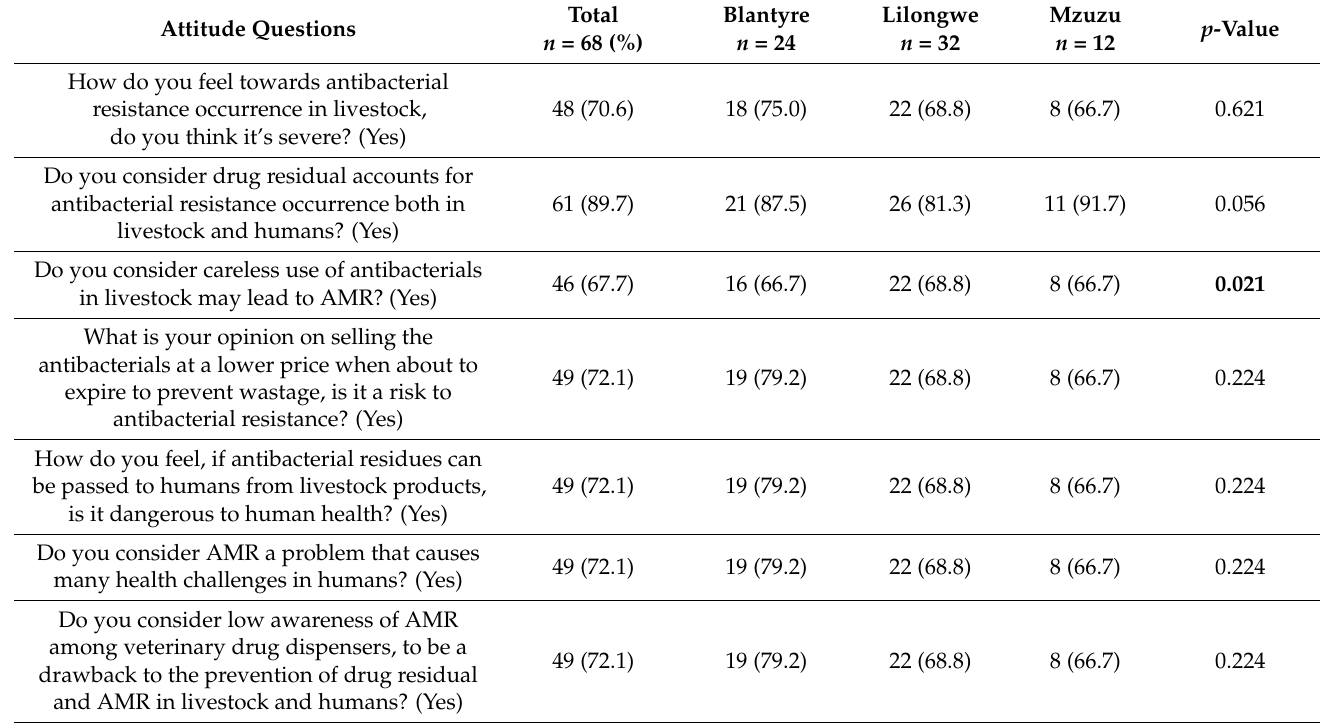
Table 4. The proportion of respondents who correctly/positively responded to attitude questions regarding dispensing of antimicrobials across the study